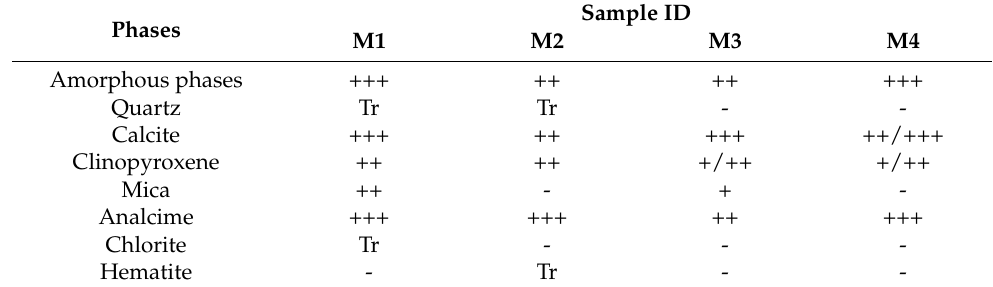
Figure 8. Microphotographs of mortar samples. ( a ) Sample M1 (a1: plane polarized light, a2, a3 crossed polarized light): fragments of pumice and black/red pozzolan are shown; ( b ) sample M2 (b1: plane polarized light, b2: crossed polarized light); ( c ) sample M3 (c1: crossed polarized light); ( d ) sample M4 (d1: plane polarized light, d2–d3: crossed polarized light). All microphotographs are at 4× magnifications. Line red bar = 1 mm.